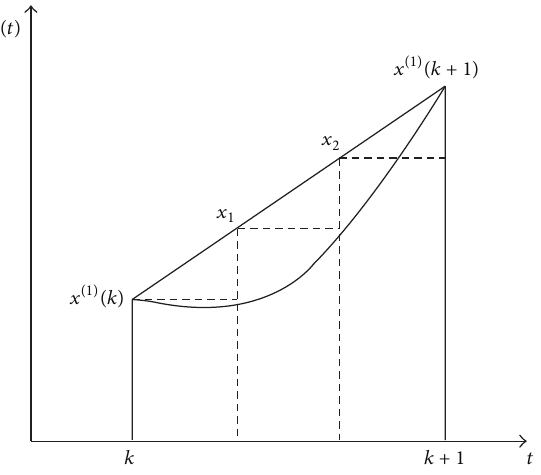
Figure 1: The concave once accumulated sequence.